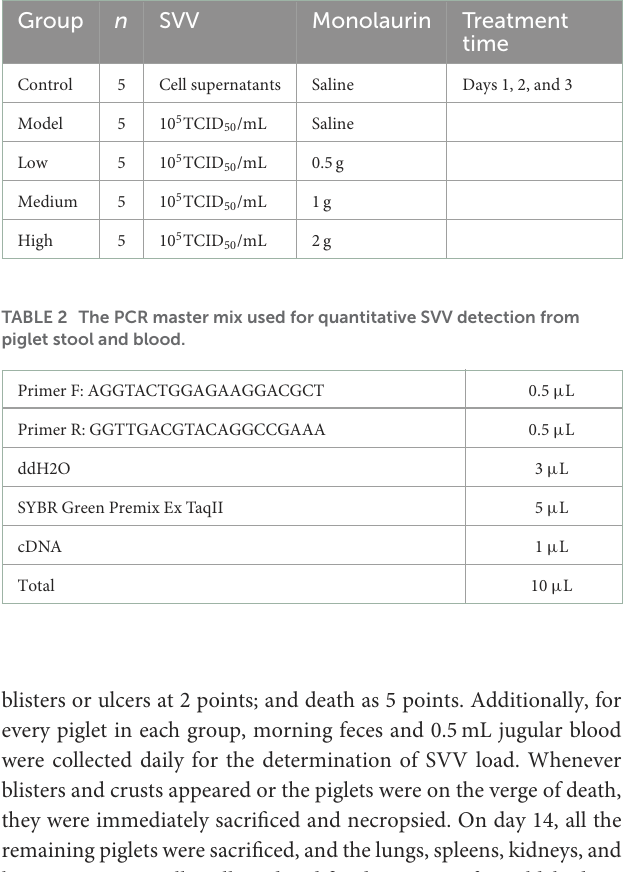
TABLE 1 Piglet grouping, viral challenge, and drug administration information. Group